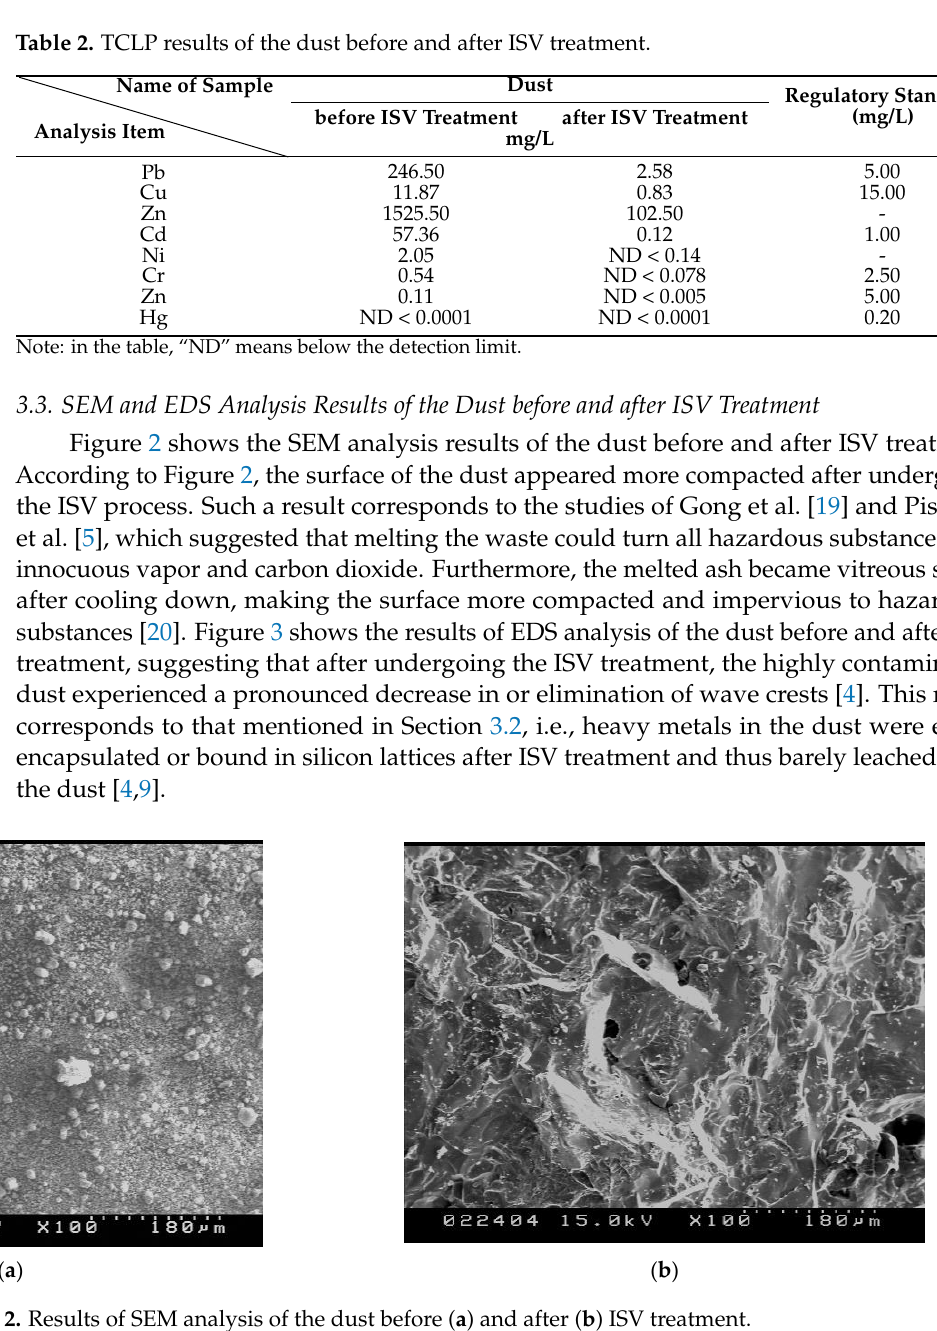
Table 2. TCLP results of the dust before and after ISV treatment.